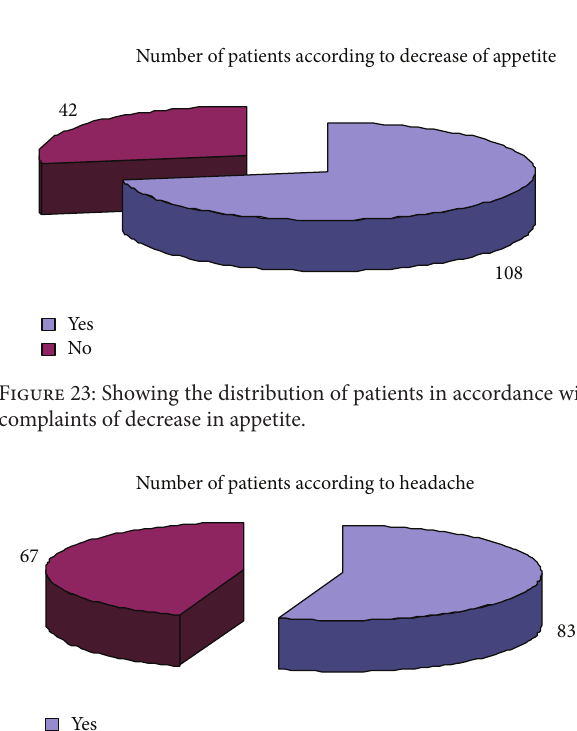
Figure 22: Showing the distribution of patients in accordance with complaints of dyspepsia.